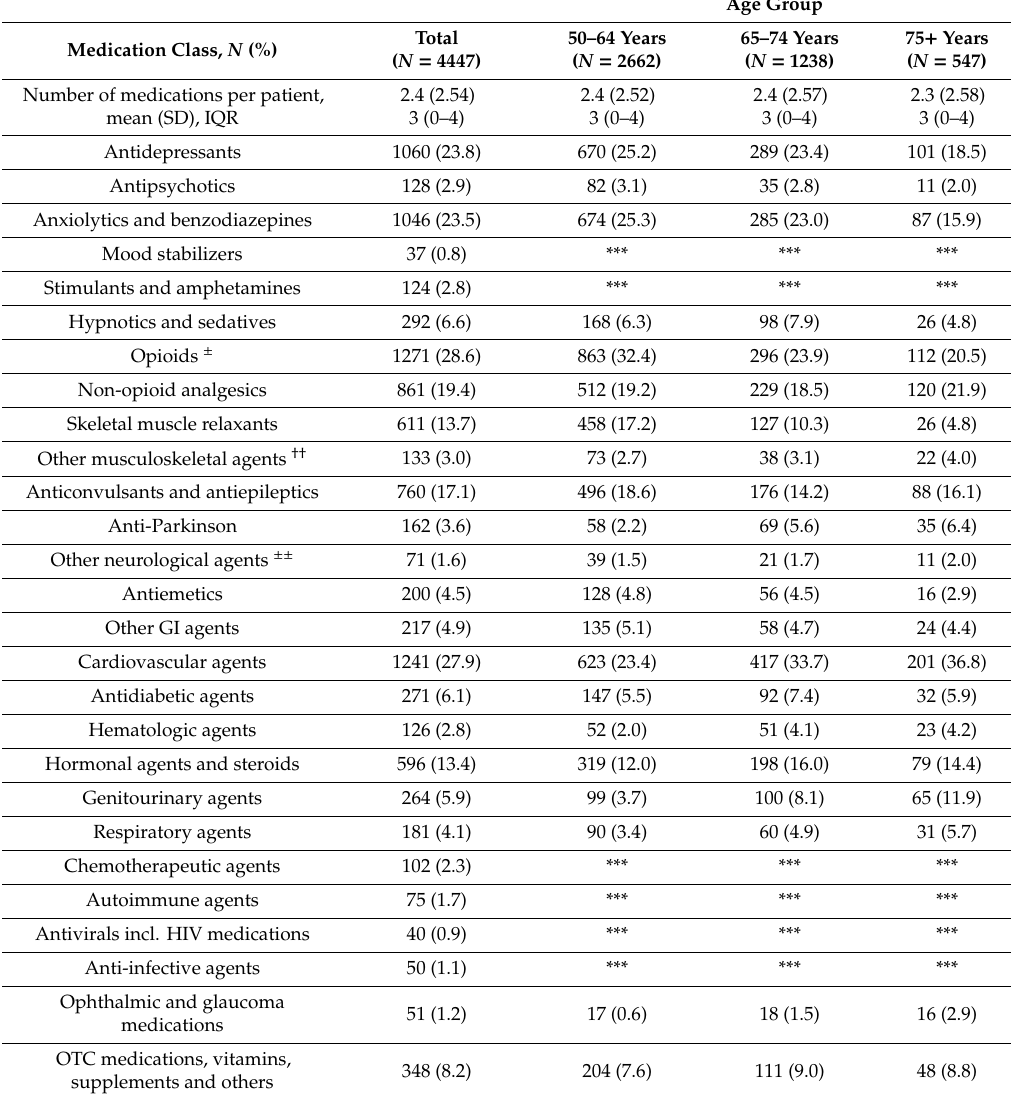
Table 3. All concomitant prescription medication classes reported to be used by Florida medical marijuana registry patients at the initial treatment visit †